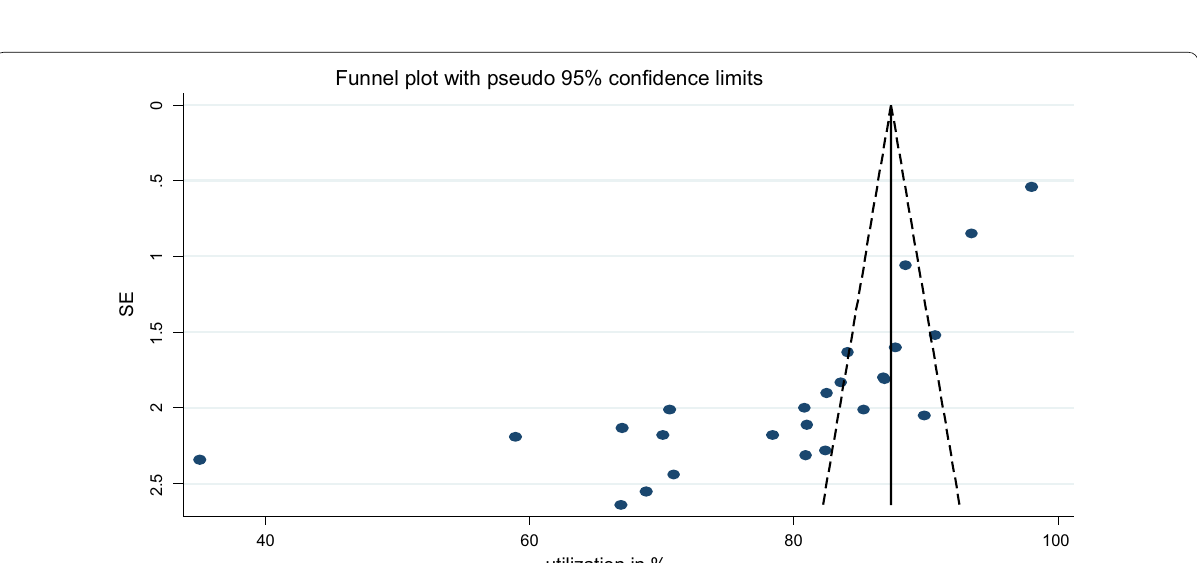
Fig. 3 Funnel plot showing publication bias states of studies included for pooled analysis of provider-initiated HIV testing and counselling in